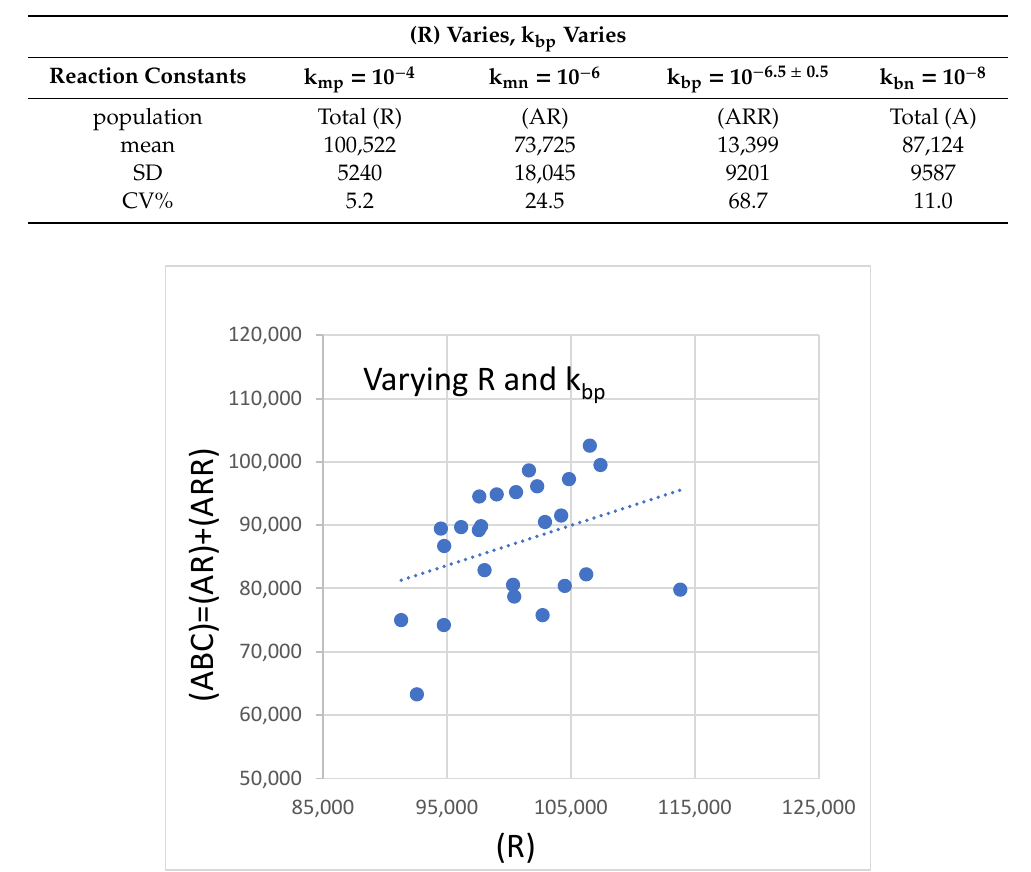
Figure 7. Equilibrium values of (AR) + (ARR) for the same calculation as in Figure 6, with the exception that the value of k bp for each calculation is taken from a normal distribution with a mean of